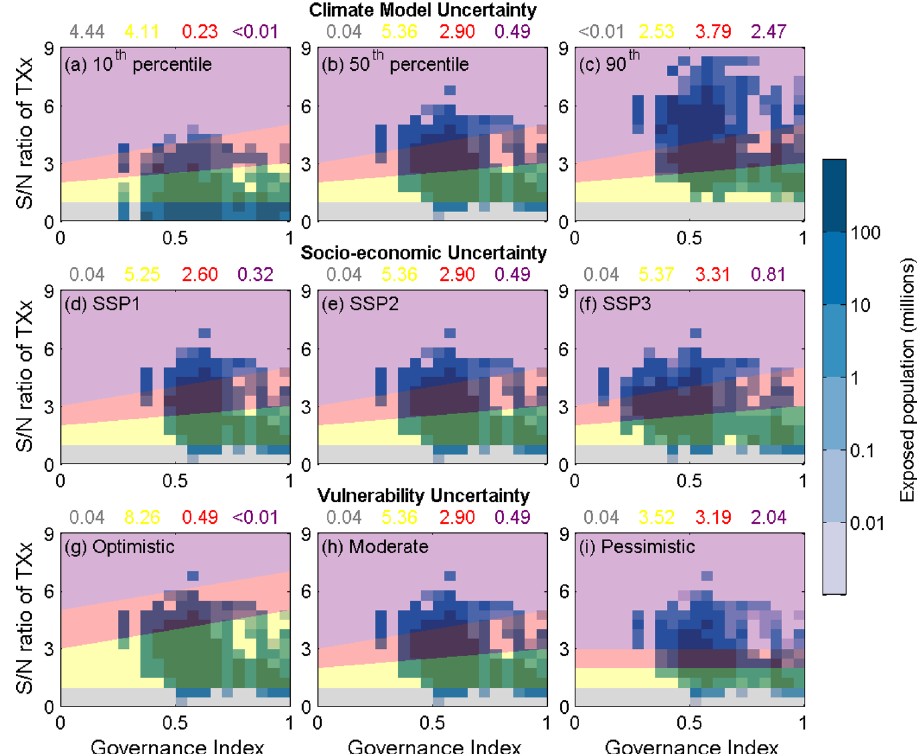
Fig. 4 Examining the individual dimensions of uncertainty affecting local risk estimates. As with Fig. 2, the background colours represent the four risk categories (grey is negligible; yellow is moderate; red is high; purple is very high) associated with different thresholds of extreme heat hazards, and governance index thresholds. Panels in the middle column ( b , e , h ) represent the same scenario as for Fig. 2: the median CMIP5 estimate of the number of people exposed to each of the four risk categories in the year 2050 under SSP2, when global temperatures are 2 °C above early industrial levels. a and c explore variations in these results due to climate model uncertainty; d , f explore variations due to alternative SSP scenarios; and g and i consider differences arising from uncertainty in the vulnerability threshold (as designated with variations of local risk thresholds in the background). The four coloured numbers above each panel denote billions of people within each of the four risk